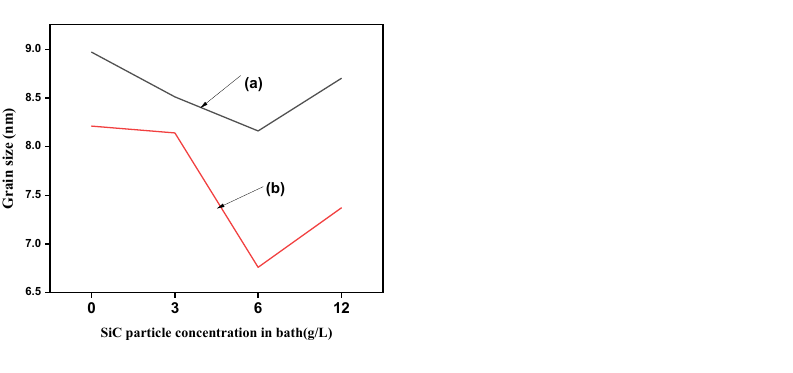
Figure 12. Grain sizes for different Ni-W/SiC composite coatings fabricated on ( a ) polished and ( b ) grit-blasted 45 steel obtained at different SiC concentrations.